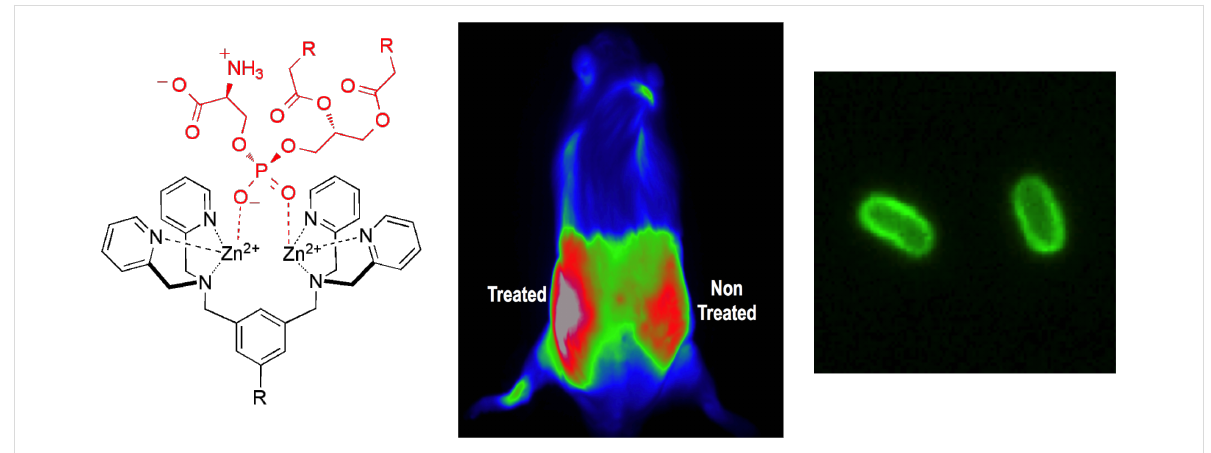
Figure 2: (left) Association of ZnDPA probe with phosphatidylserine head group. (middle) False colored fluorescence image of a living rat bearing two tumors. There is increased accumulation of the cell death probe in the tumor that has been treated by focal beam radiation. (right) Fluorescence image of bacterial cells stained with fluorescent ZnDPA